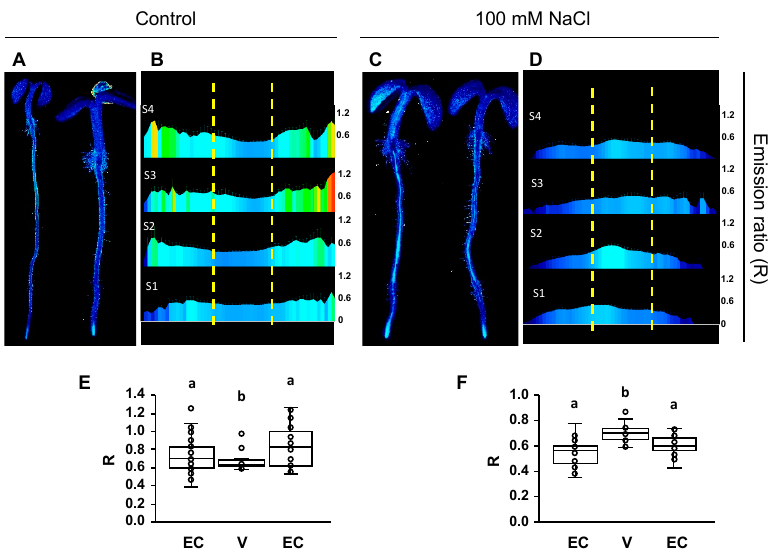
Figure 5. pHcyt maps of whole seedlings expressing the pH-sensor pHGFP-LTI6b. Fluorescence emission ratios after sequential excitation at 405 and 488 nm (R) of pHGFP-LTI6b in 4-day-old seedlings 16 h after being transferred to LAK media ( A , B , E ) or supplemented with 100 mM NaCl ( C , D , F ). ( A , C ) Representative seedlings grown in LAK medium ( A ) or LAK supplemented with NaCl ( C ). ( B , D ) Profile of root sectors showing average emission ratios (R) from at least 6–8 seedlings per treatment; the root zones S1 to S4 are named as in Supplemental Figure S3; the scales of R values are shown on the right; yellow lines indicate the division used to analyze the vasculature (center) and the epidermis and cortex (flanks). ( E , F ) Box plots indicating the mean of the emission ratios (R) in different tissues for each condition. The mean was obtained from the aggregated sectors S1–S4 shown in the images above. EC: epidermis and cortex; V: vasculature. Different letters indicate groups with significantly different values according to Tukey HSD test at p < 0.05.